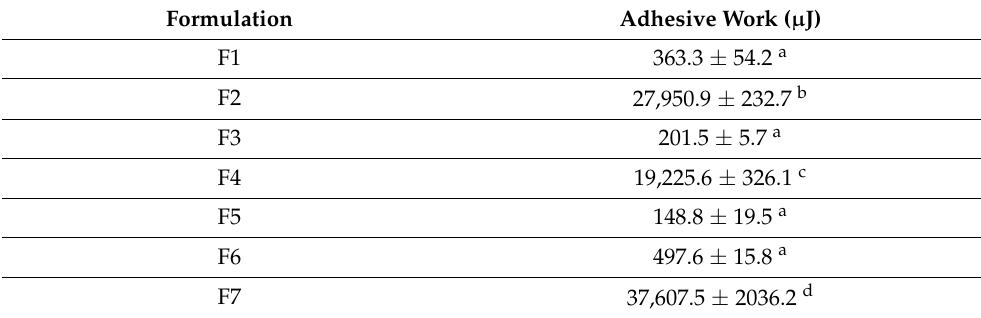
Table 5. Adhesive work of formulations determined using hairless mouse skin (mean ± SD, n = 6).